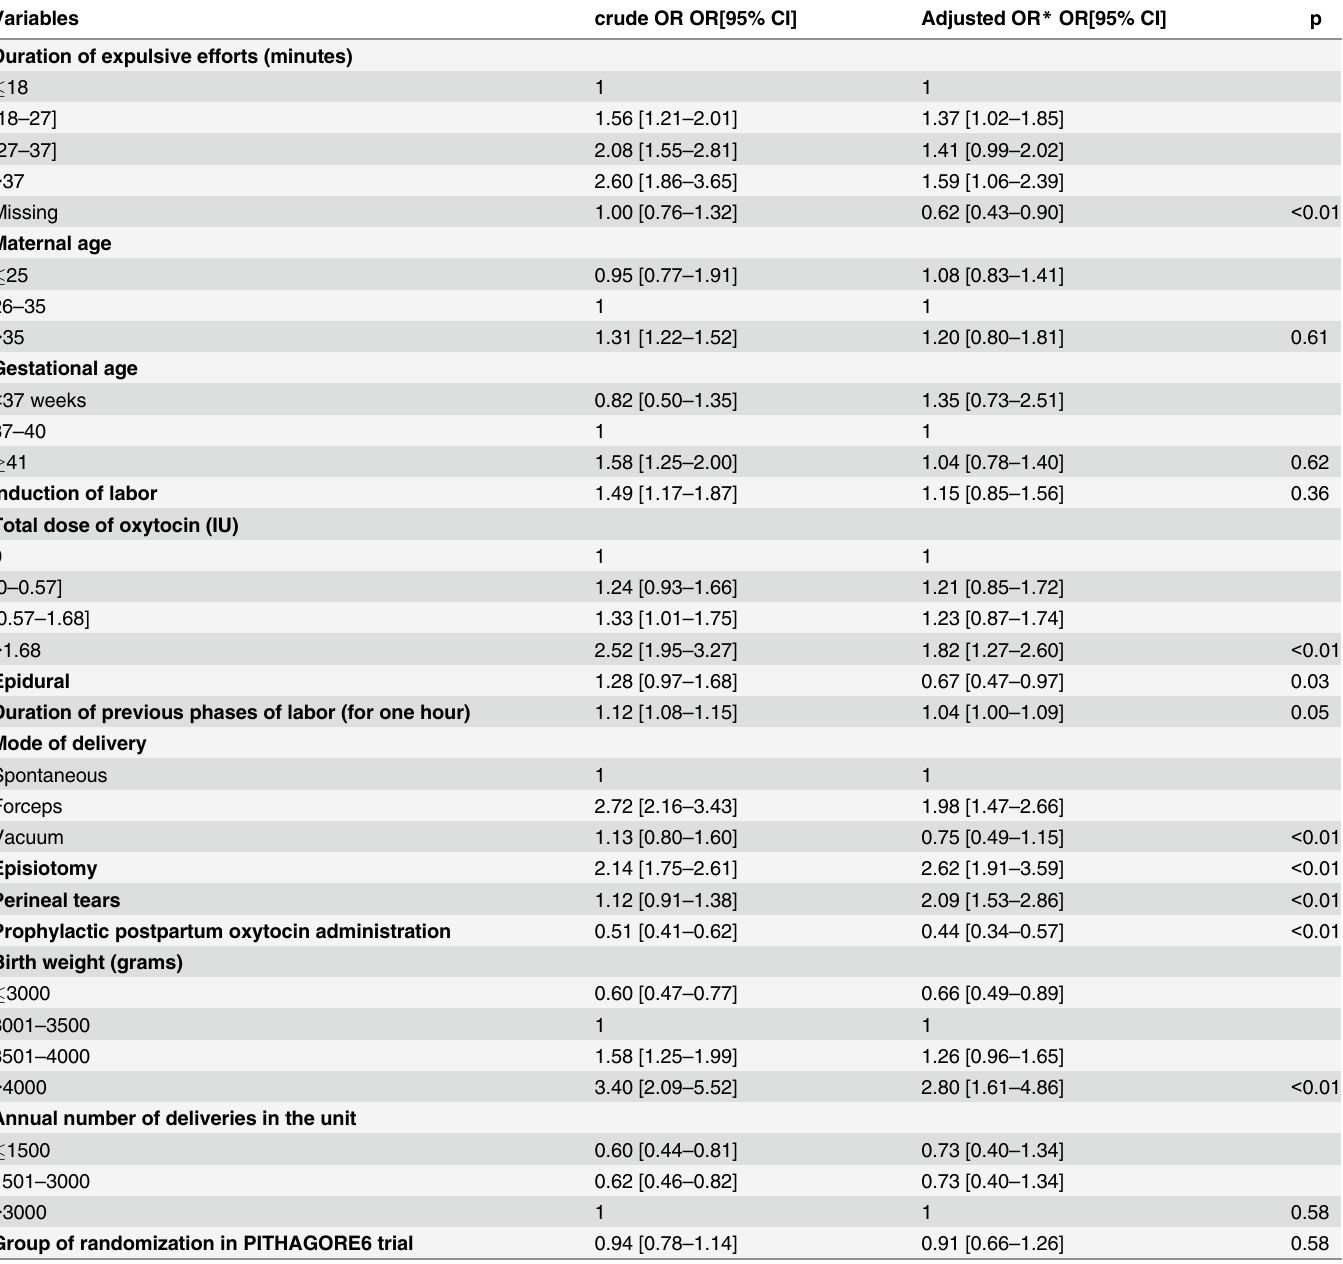
Table 4. Association between duration of expulsive efforts and risk of severe PPH – univariable and multivariable analysis (n = 1699; 998 severe PPH and 701 controls).